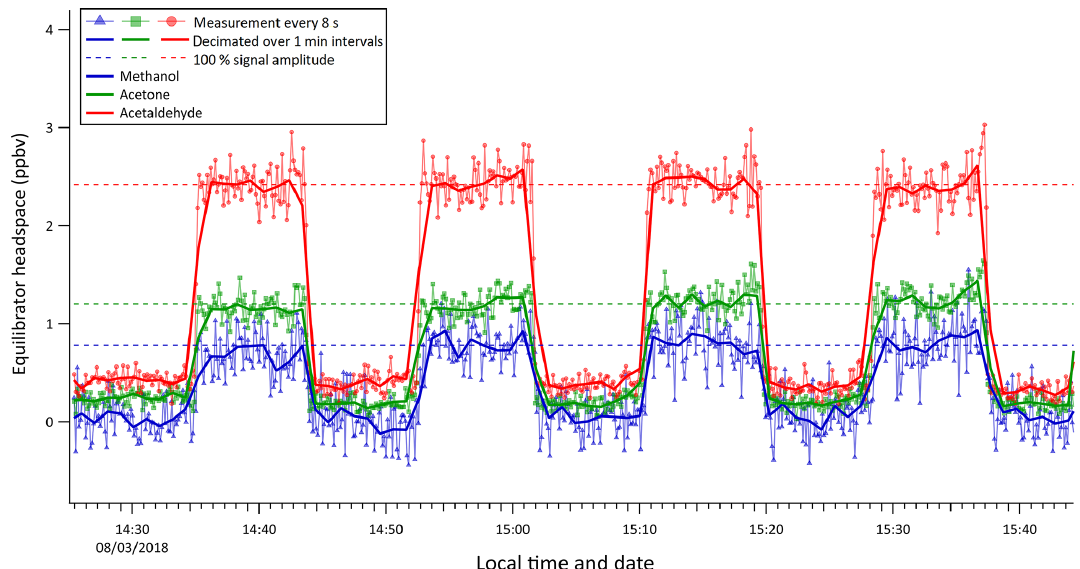
Figure 6. Instrument response to step changes in Milli-Q water OVOC concentration (step size: 20nmoldm − 3 acetone, 20nmoldm − 3 acetaldehyde, 200nmoldm − 3